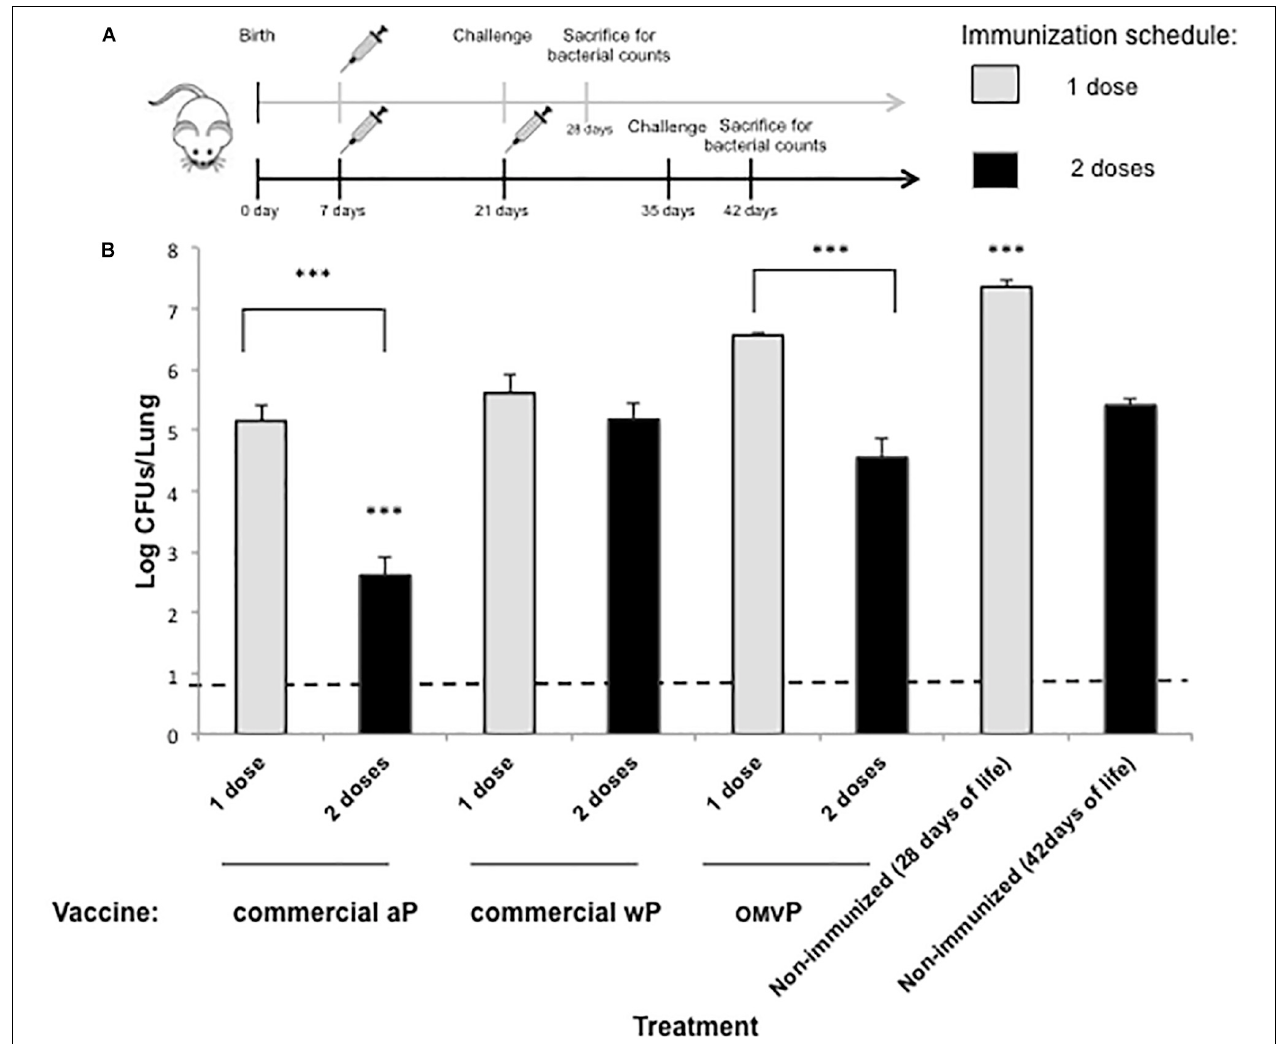
FIGURE 1 | Effect of neonatal immunization on the protection of offspring against Bordetella pertussis infection. (A) Schematic representation of vaccination and challenge protocols. Seven-day-old neonatal mice were vaccinated with a commercial aP, OMV P or a commercial wP vaccines ( n = 8 in each group). For the two-dose vaccination schedules consisting in two doses, the second dose (black horizontal arrow) was administered 14 days after the first dose. Mice immunized with 1 dose (gray horizontal arrow) or 2 doses (black arrow) were challenged with B. pertussis at 28 and 35 days after birth, respectively. Non-immunized mice of the same age (used as a negative control for protection) were also challenged with B. pertussis . (B) Protection of offspring through the vaccination schedules of (A) . The number of bacteria recovered from the mouse lungs, expressed as the log 10 (CFUs per lung), is plotted on the ordinate for the type and vaccine schedule indicated on the abscissa , with the data representing the means ± the SD. The dotted horizontal line demarcates the lower limit of detection. ∗∗∗ p < 0.001 for both the non-immunized mice versus the 1-dose–immunized mice and the aP-immunized mice versus all the other treatments performed for the 2-dose–schedule